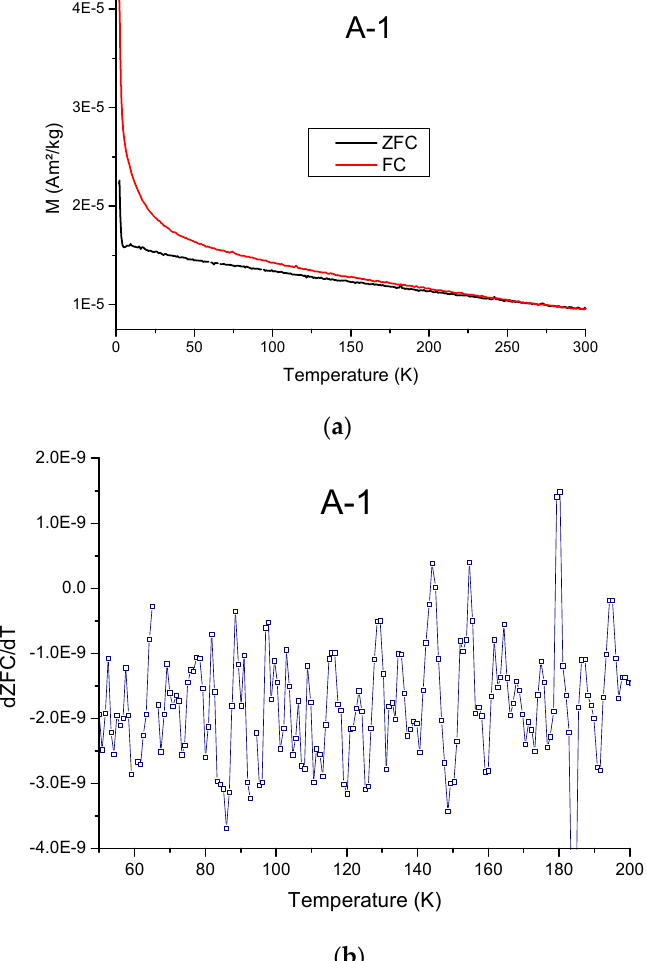
Figure 11. ( a ) Low temperature remanence data for South-Ural glass; ( b ) remanence derivative from a) Figure 11. a ) Low temperature remanence data for South-Ural glass; b ) remanence derivative from showing lack of a) showing lack of transition.